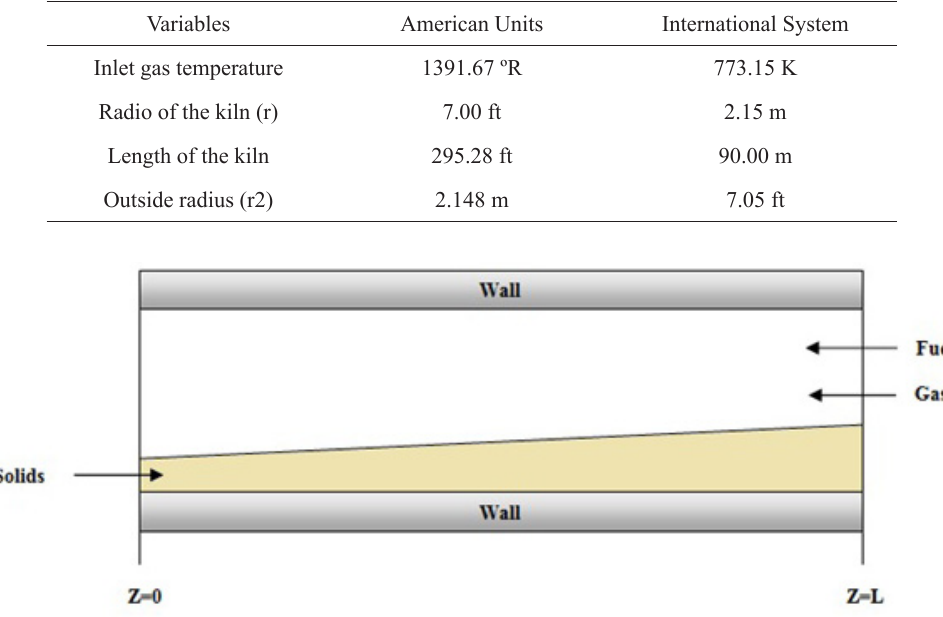
Figure 1 - Volume control used in the mathematical modelling of the rotary kiln (adapted from Spang